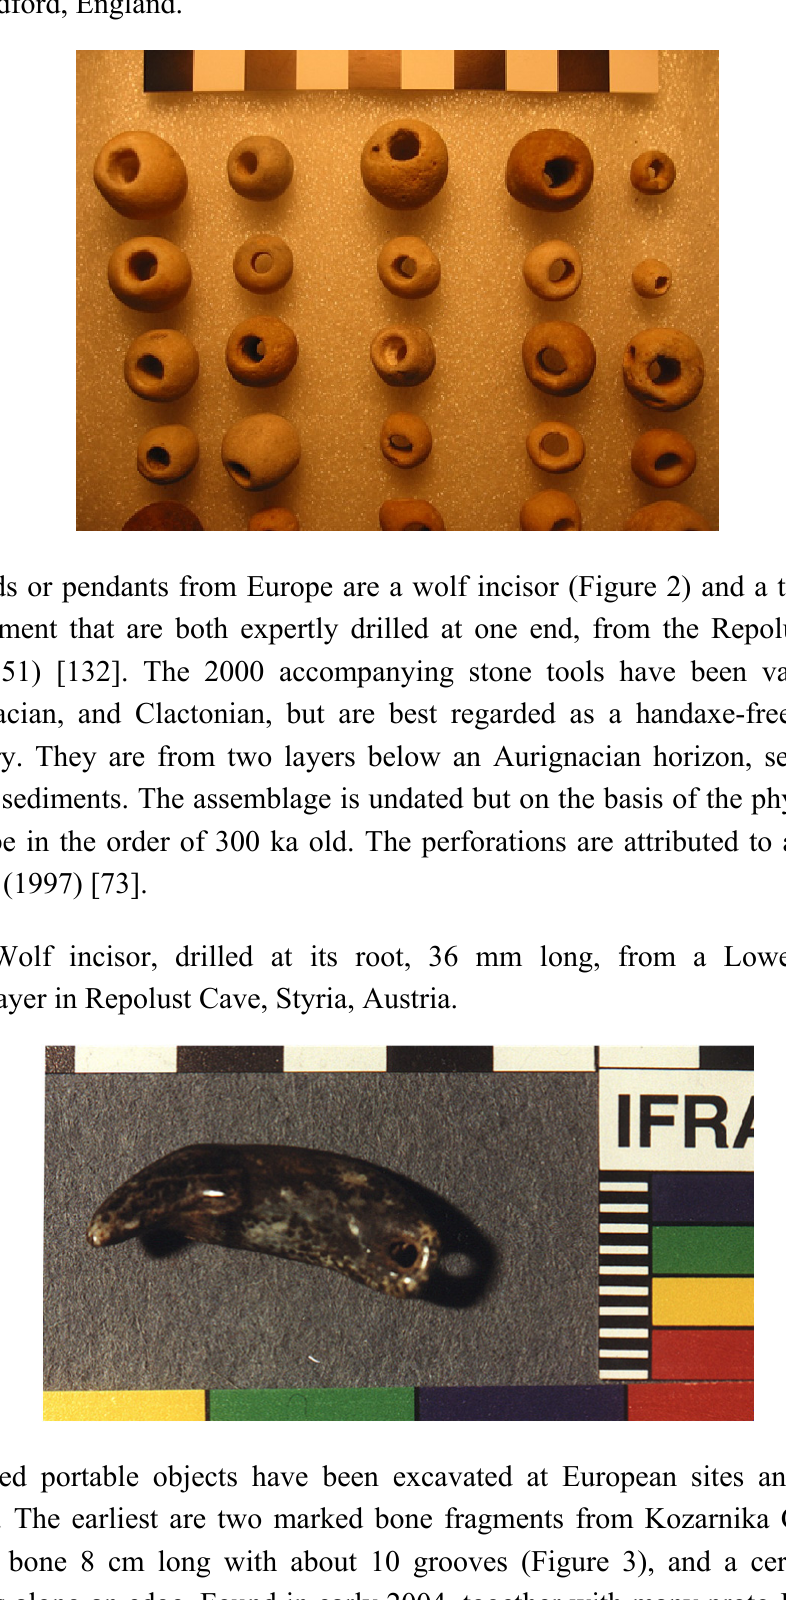
Figure 1. Perforated Porosphaera globularis fossils from the Acheulian of Biddenham quarry at Bedford, England.